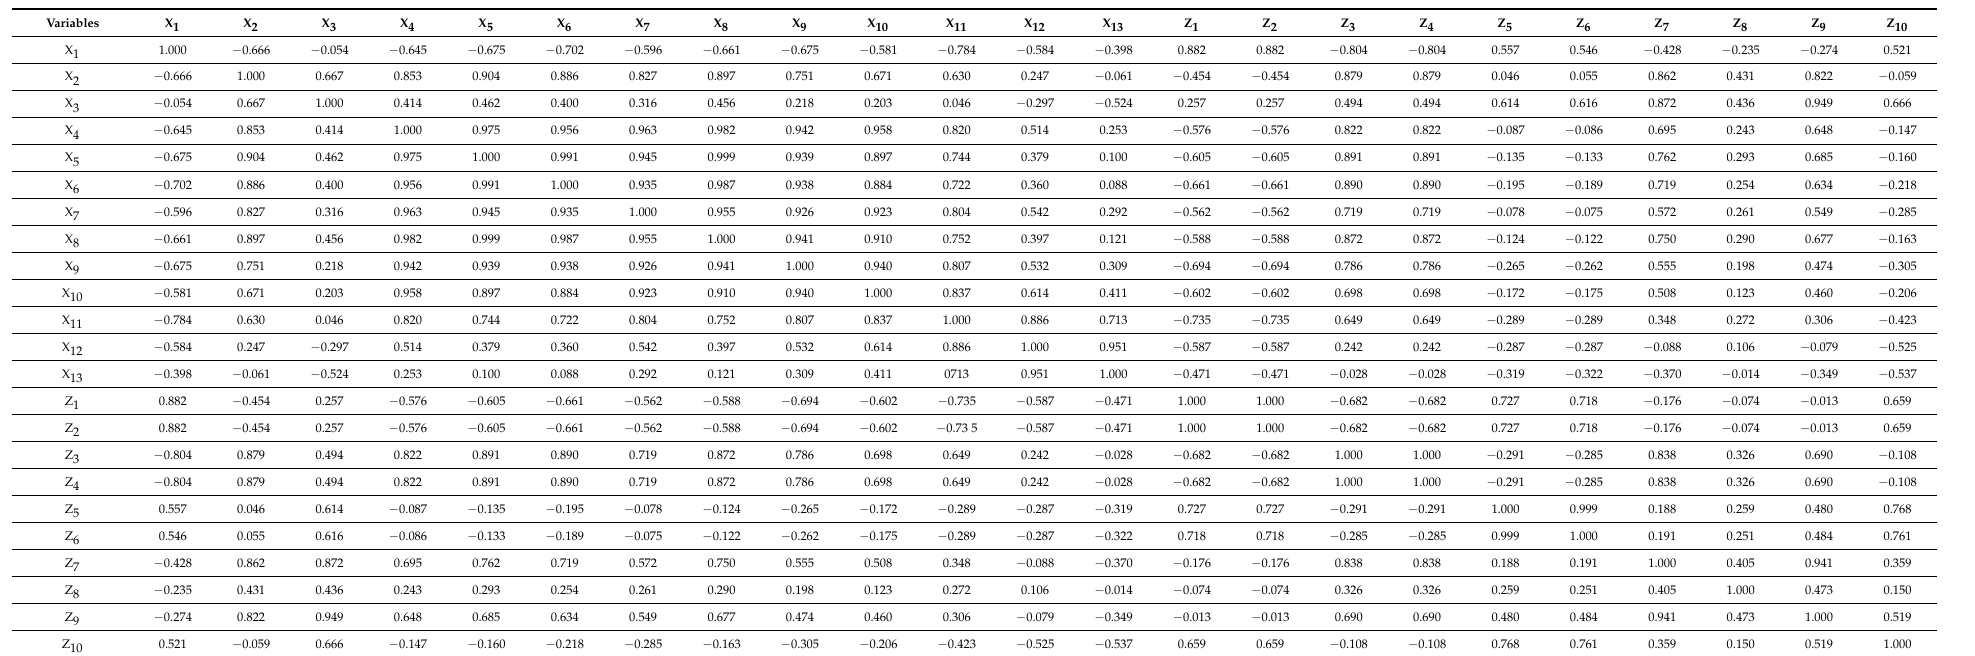
Table A8. Correlation matrix of variables describing mixed production